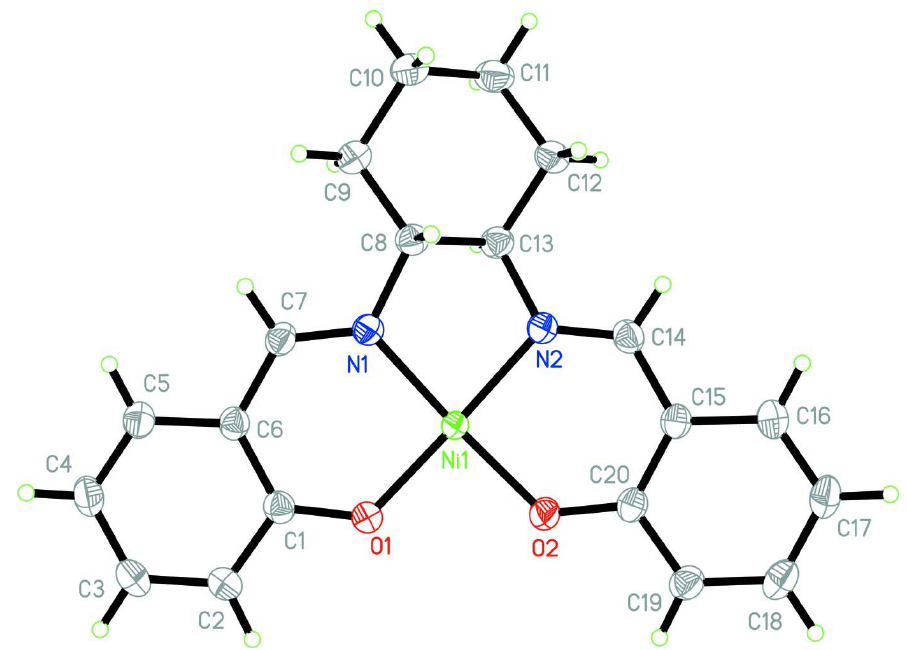
The structure of (I), showing the atom-numbering scheme. Displacement ellipsoids are drawn at the 30% probability